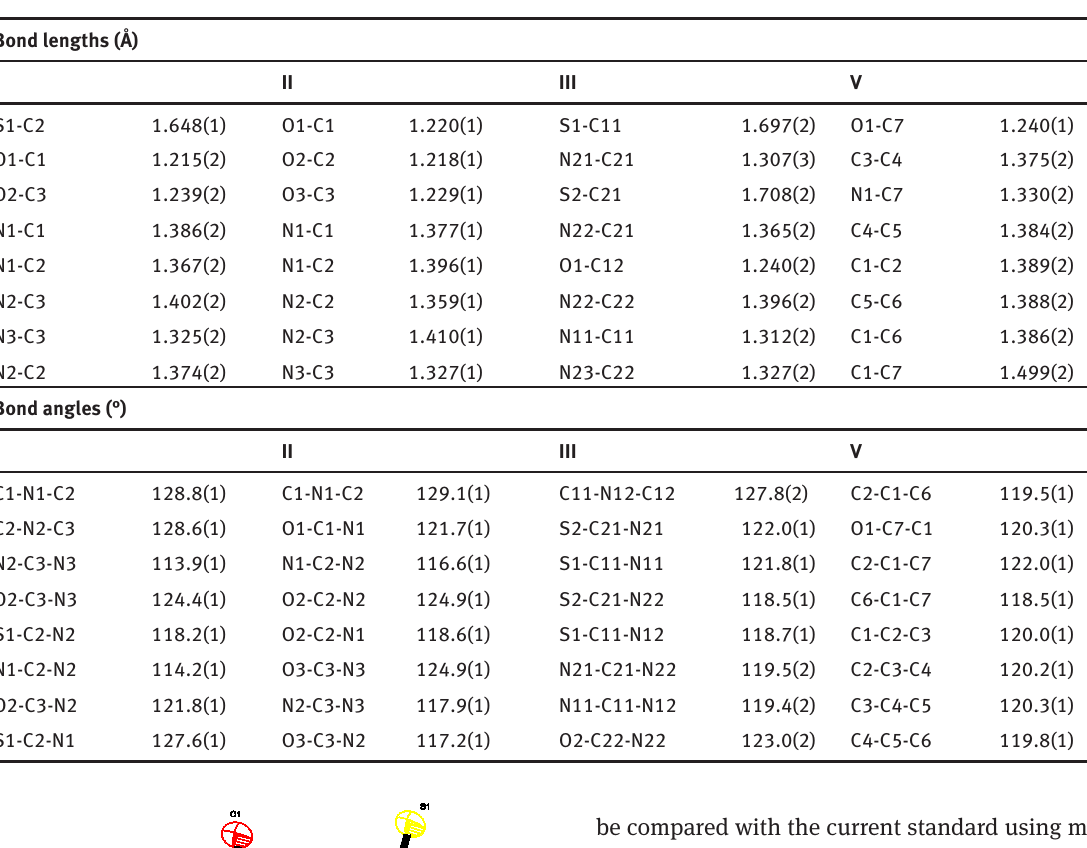
Table 2: Selected bond lengths (Å) and bond angles (°) for compounds I , II , III and V .